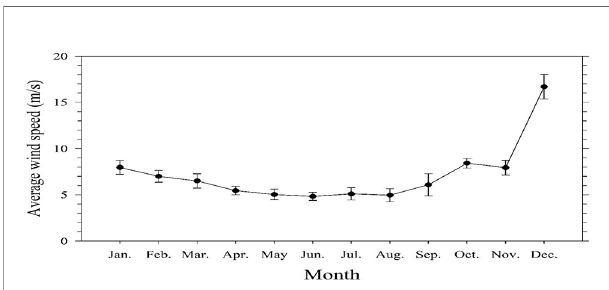
FIGURE 7 | The average 15-year (2005-2019) monthly wind speed at a height of approximately 15 m above the sea surface from the meteorological platform.